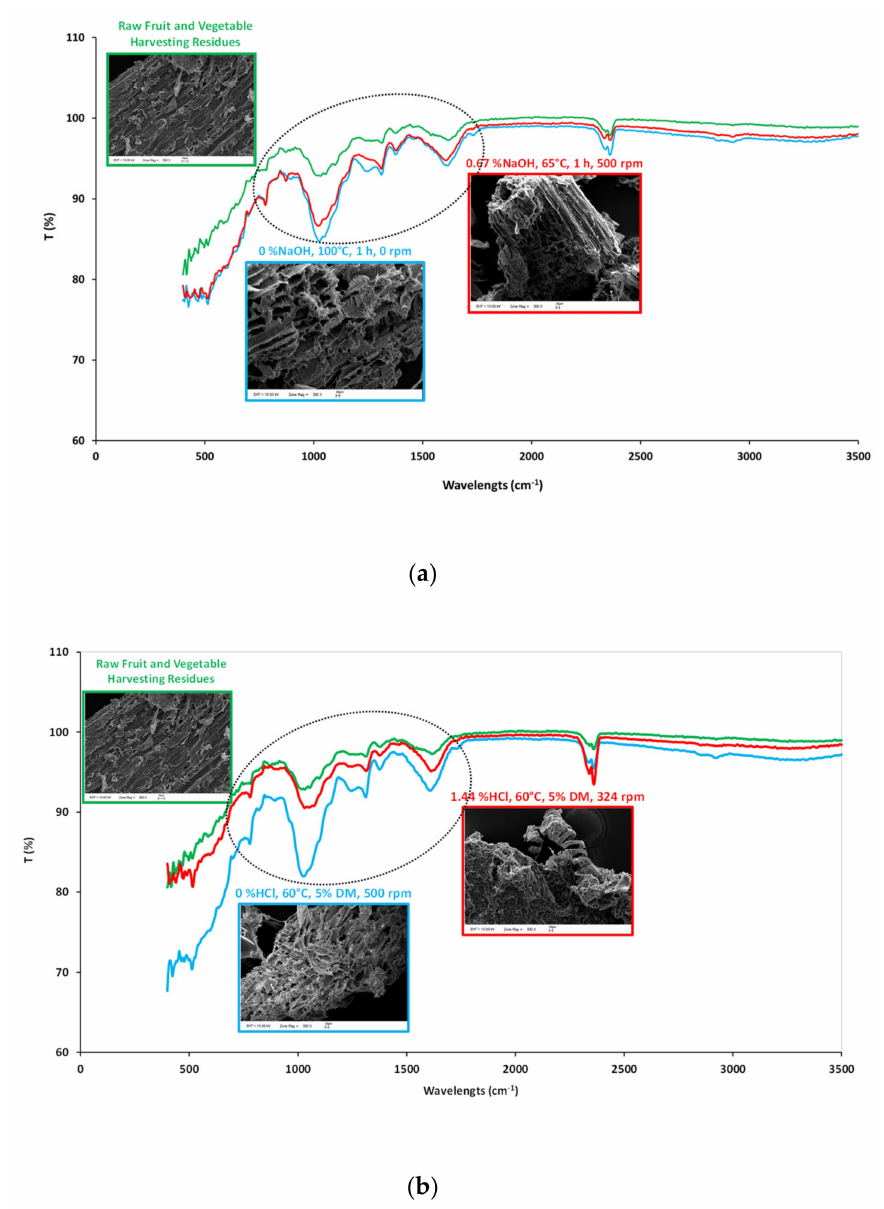
Figure 4. SEM images and FTIR spectra of raw and pretreated FVHW at 0% NaOH concentration, 100 ◦ C reaction temperature, 1 h reaction time and no mixing, and 0.67% NaOH concentration, 65 ◦ C reaction temperature, 1 h reaction time and 500 rpm mixing speed conditions ( a ); SEM images and FTIR spectra of raw and pretreated FVHW at 0% HCl concentration, 60 ◦ C reaction temperature, 5% DM content and 500 rpm mixing speed and 1.44 %HCl concentration, 60 ◦ C reaction temperature, 5% DM content and 324 rpm mixing speed conditions ( b